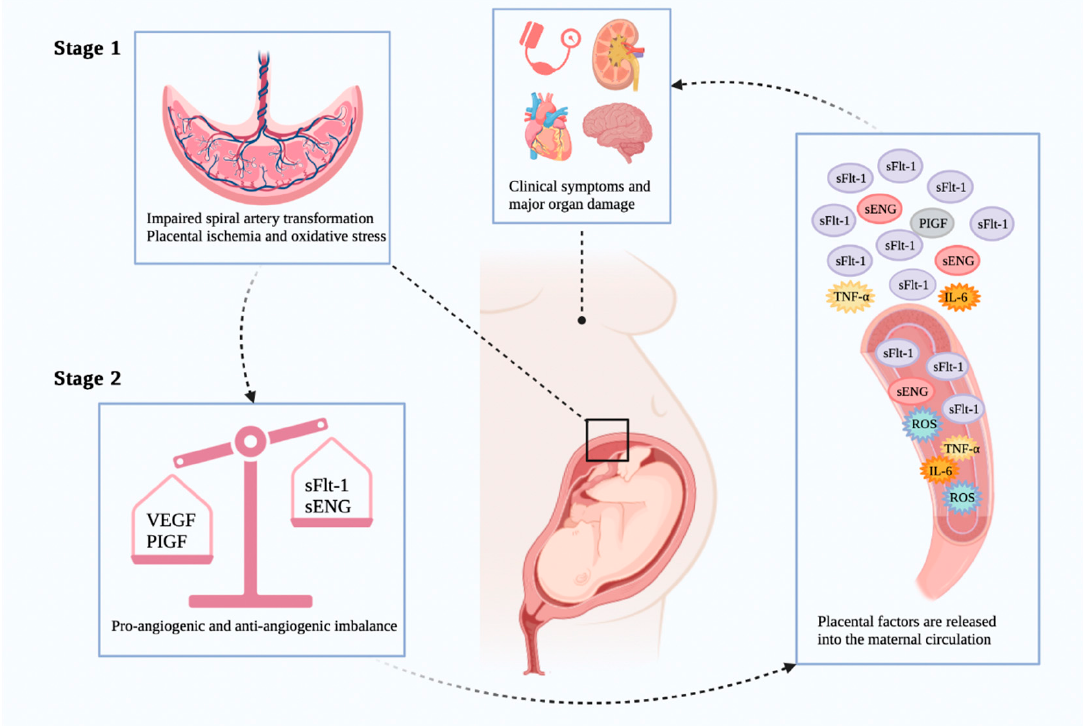
Figure 3. The two-stage model of PE pathogenesis. Image was created with BioRender.com (ac- cessed on 25 June 2022). VEGF: vascular endothelial growth factor; PIGF: placental growth factor; sFlt-1: soluble fms-like tyrosine kinase-1; sENG: soluble endoglin; ROS: reactive oxygen species; IL-6: interleukin-6; TNF- α : tumor necrosis factor- α .